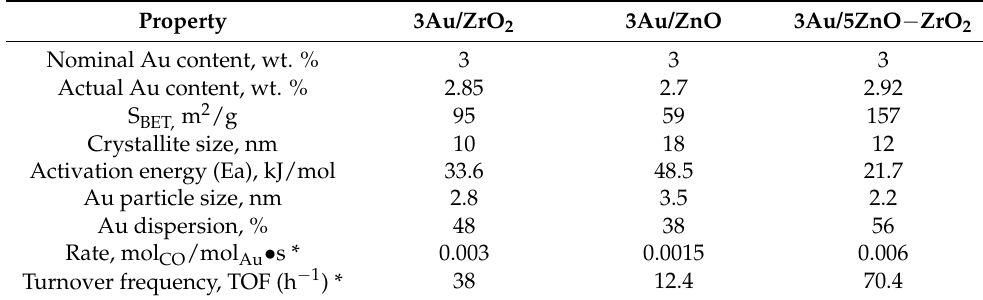
Figure 1. XRD patterns of the 3Au/ZrO 2 , 3Au/ZnO, and 3Au/5ZnO − ZrO 2 catalysts. Table 1. Properties of the 3Au/ZrO 2 , 3Au/ZnO, and 3Au/5ZnO − ZrO 2 catalysts annealed at 200 °C under air atmosphere, as well as kinetic data regarding the CO oxidation